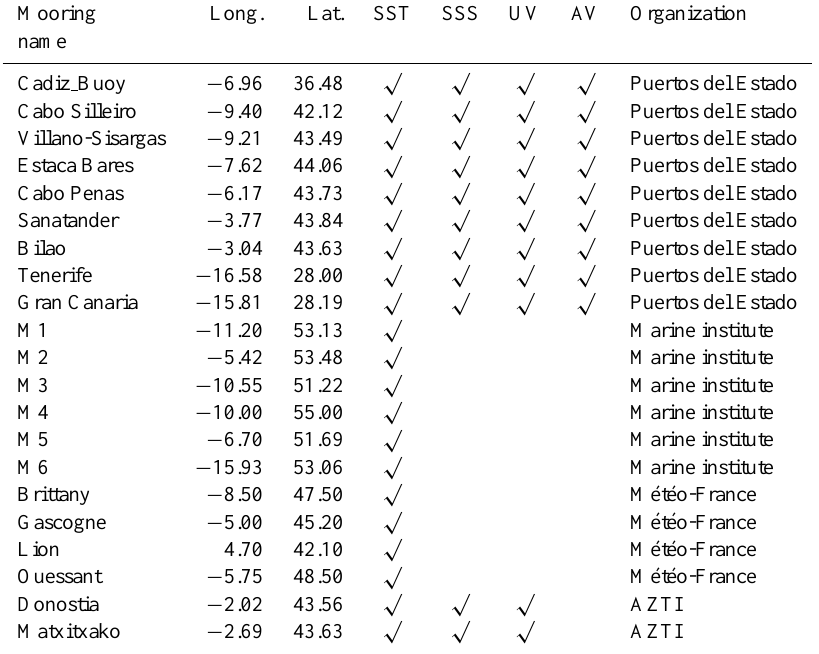
Table 4. List of in situ buoys used in this study. For each buoy, the longitude, latitude, and variables available at the station and the organization providing the data are indicated. The available variables are: sea surface temperature (SST), sea surface salinity (SSS), currents ( U,V ) at the surface for Puertos del Estado buoys, temperature, salinity and currents profiles in the upper 200m for AZTI buoys and atmospheric variables (AV) that include air temperature, atmospheric pressure and wind velocity. AZTI data include 18 depth levels of measurements in the upper 150m for the currents (12, 20, 28, 36, 44, 52, 60, 68, 76, 84, 92, 100, 108, 116, 124, 132, 140 and 148m) and measurements at 10, 20, 30, 50, 75, 100 and 200m for temperature and